Question: Which kind of chart has been used to present this data?
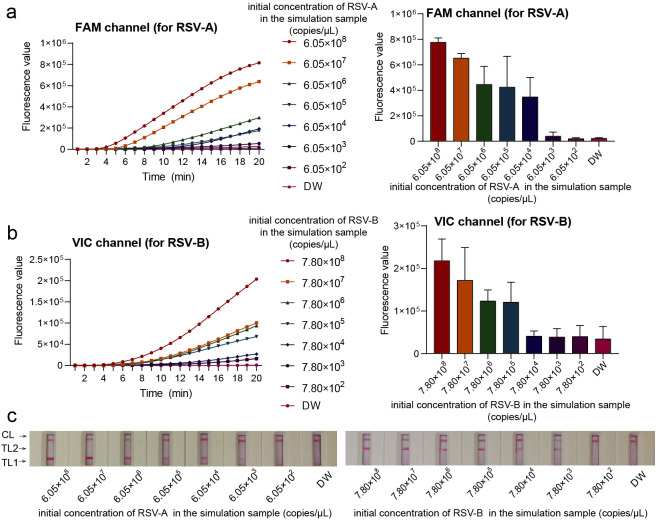
Answer: line